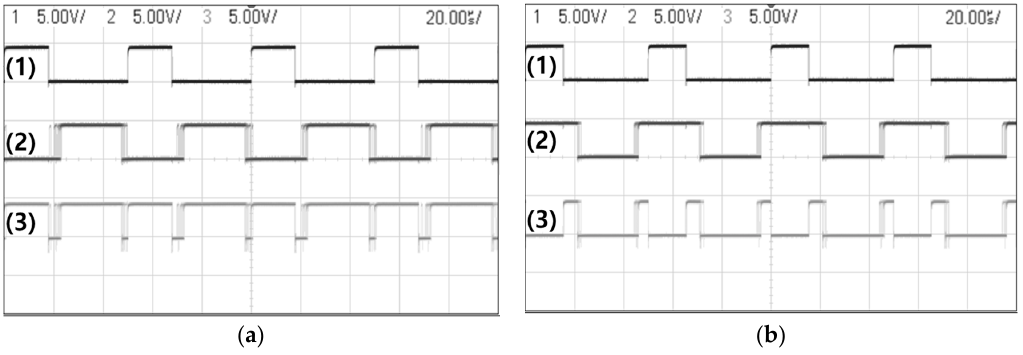
Figure 23. Oscilloscope readings from the second experiment showing the converted logic waveform of the ( 1 ) load coil; ( 2 ) sensor coil; and ( 3 ) the XOR gate output for ( a ) left misalignment; and ( b ) right misalignment.